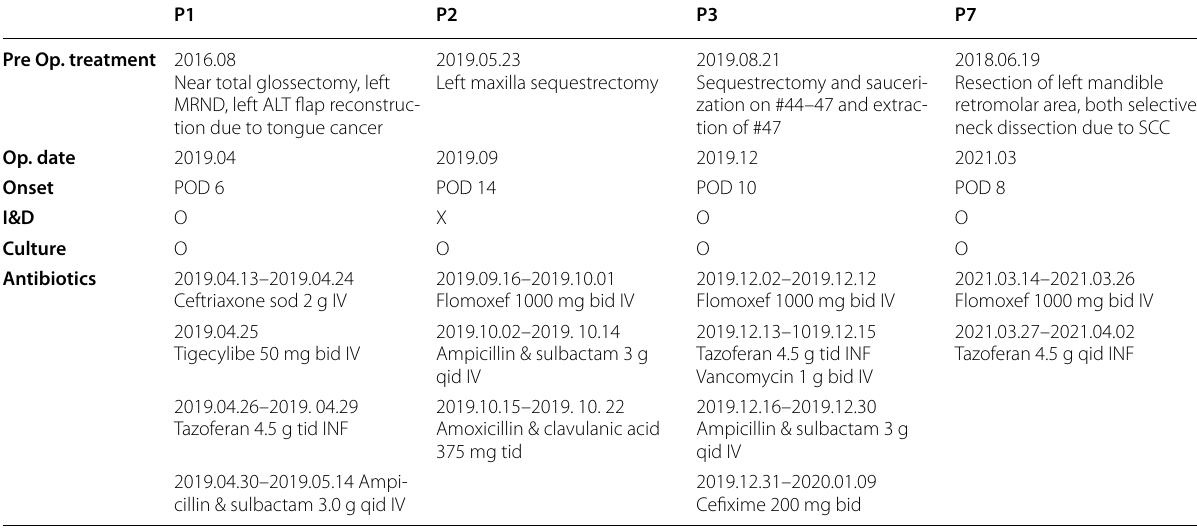
Table 4 Summary of patients with postoperative